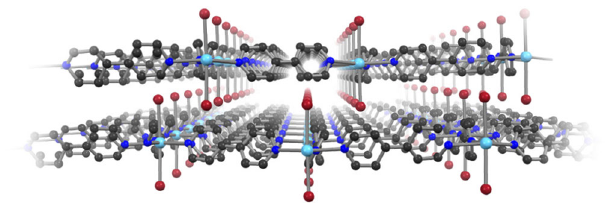
Fig. 3 Perspective view of the 2D nature of 1. Layers of 1 in which the iodide ligands point towards the cavities of the adjacent layers. ∠ I – Yb – I 175.60(1)°. (Yb, light blue; I, dark red; N, blue; C, gray; hydrogen atoms and co-crystallized CH 3 CN have been omitted for clarity).